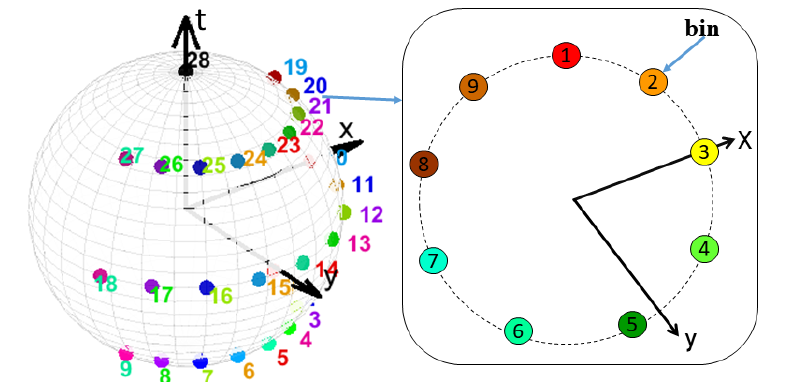
Figure 3. 28 orientation bins along latitude and longitude on a hemisphere. 4 orientation bin layers including a layer at pole are in two-dimensional x − y plane. 9 orientation bins are located on each layer except at the pole (contains one